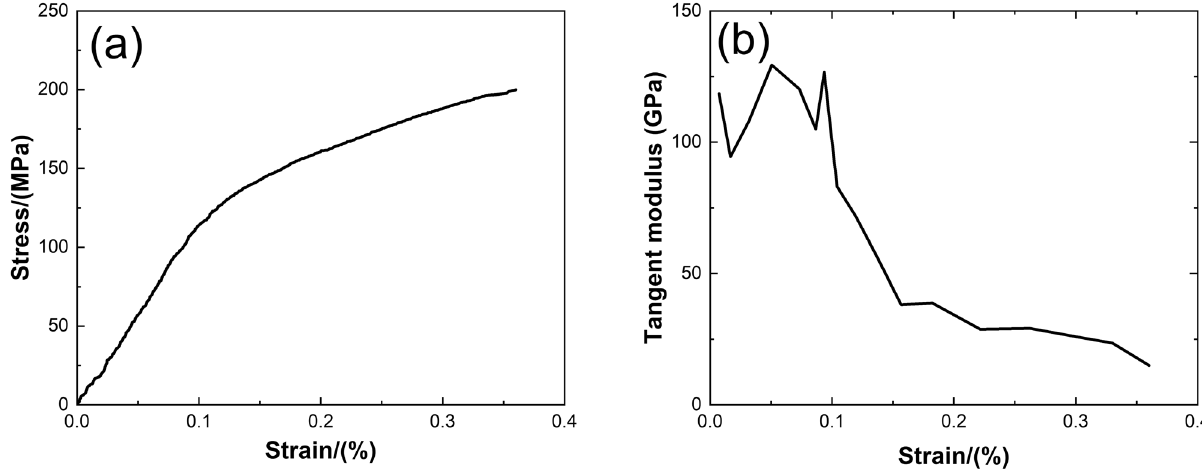
Figure 5: ( a ) Tensile curve; and ( b ) tangent modulus versus strain curve of 2D plain - woven CVI - SiC/SiC composite at an elevated tem - perature of T = 900°C in air